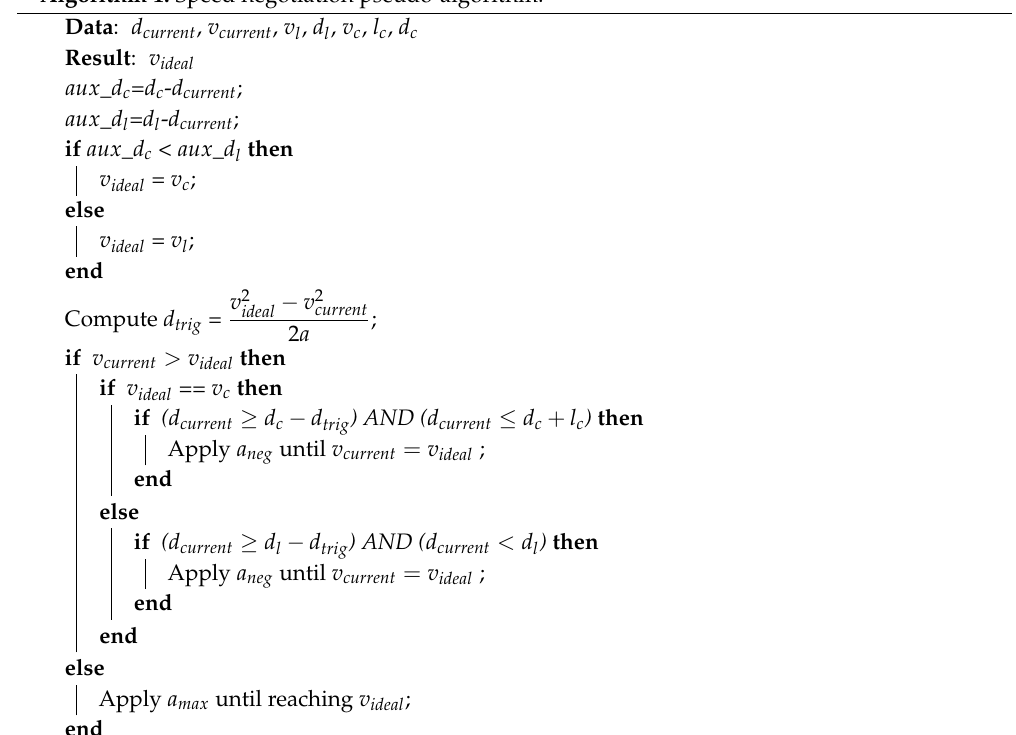
Algorithm 1: Speed negotiation